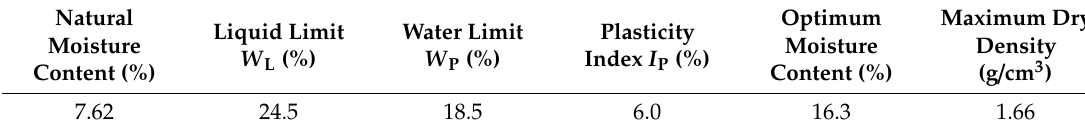
Table 3. Physical properties of loess.